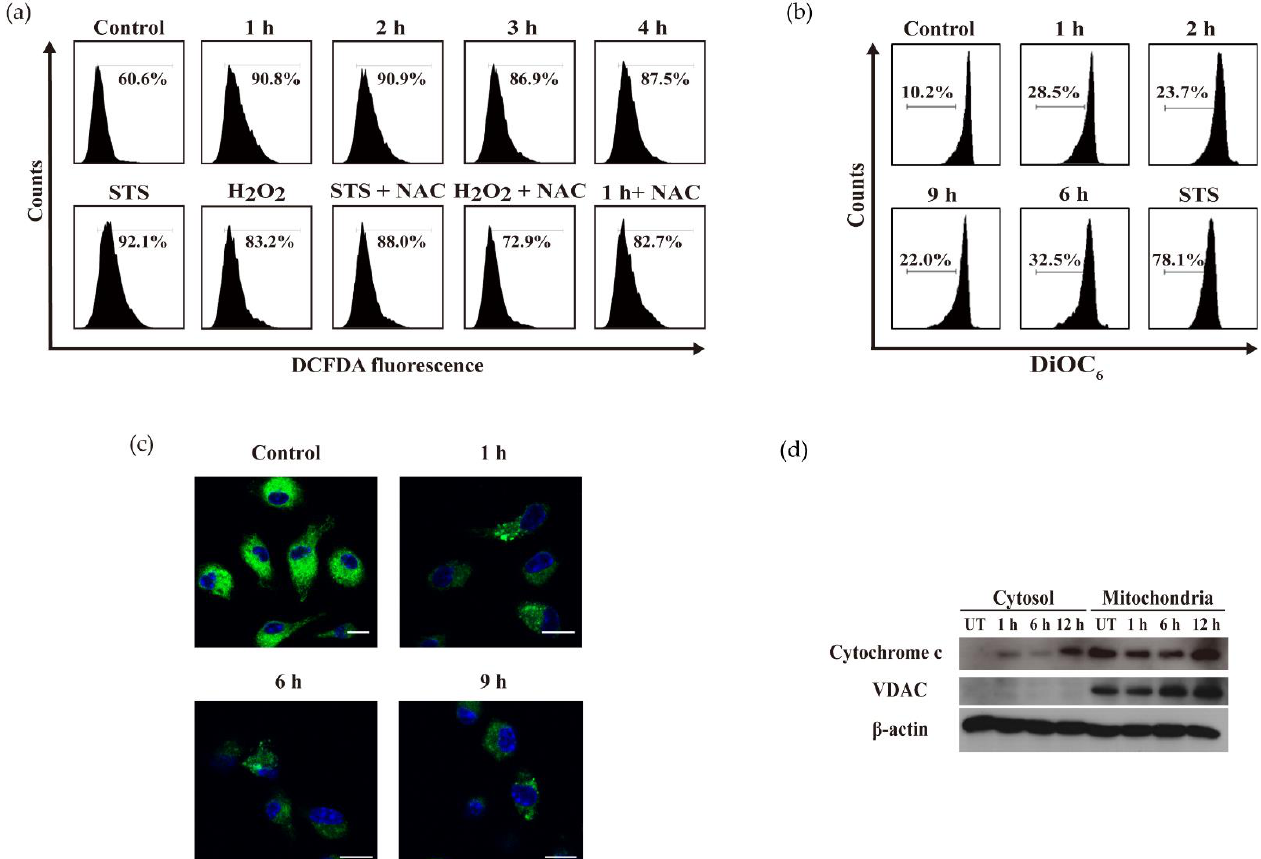
Figure 5. OH-dDHL induced ROS production and mitochondrial dysfunction in BMDMs. ( a ) BMDMs were treated with 50 µM OH-dDHL in a time-dependent manner; STS (500 nM) and H 2 O 2 (850 µM) for 4 h were used as positive controls; NAC (10 mM) stained with CM-H 2 DCFDA for ROS analysis followed by flow cytometry. ( b ) BMDMs were treated with 50 µM OH dDHL and stained with 3, 3′ -dihexyloxacarbocyanine iodide DiOC 6 . Cells were analyzed using flow cytometry. ( c ) BMDMs were treated with 50 µM OH-dDHL and imaged with a confocal microscope using the FITC channel. Scale bar, 10 µm. ( d ) BMDMs were treated with 50 µM OH-dDHL in a time-dependent manner. Cytochrome c analyzed using Western blot in cytosol fraction and mitochondria fraction. UT; negative control.